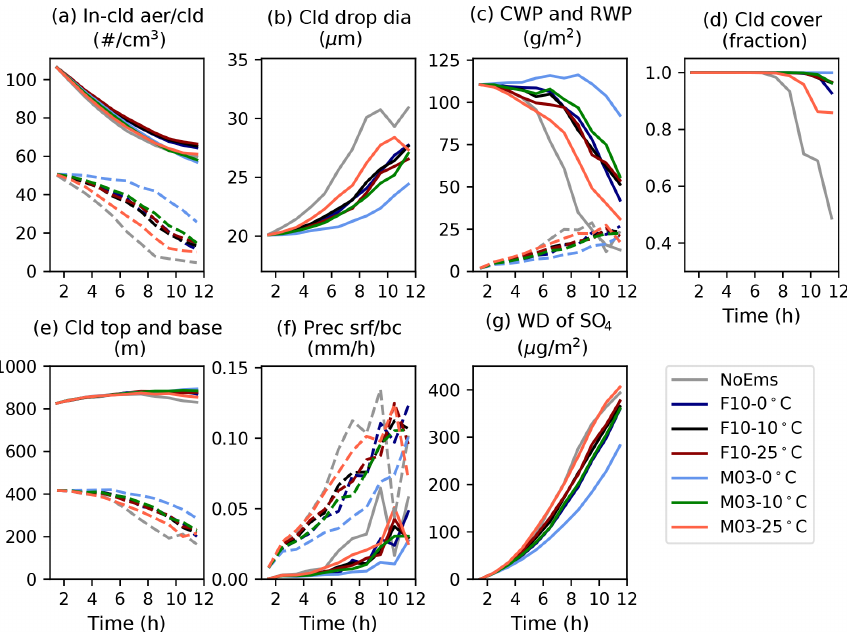
Figure 4. Impact of sea surface temperature based on Forestieri et al. (2018) (dark colours) and Mårtensson et al. (2003) (light colours). Panels are the same as Fig. 3. Temperatures from cold to warm: blue: 0 ◦ C, green/black: 10 ◦ C, and red: 25 ◦